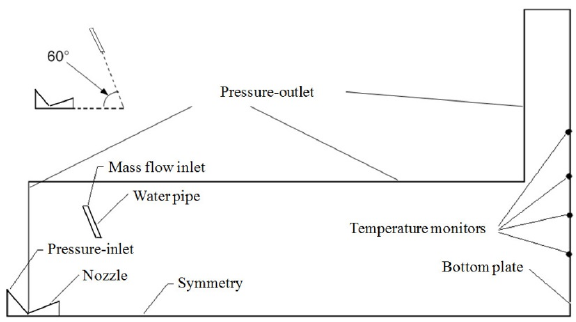
Figure 1. Schematic of the boundary condition.